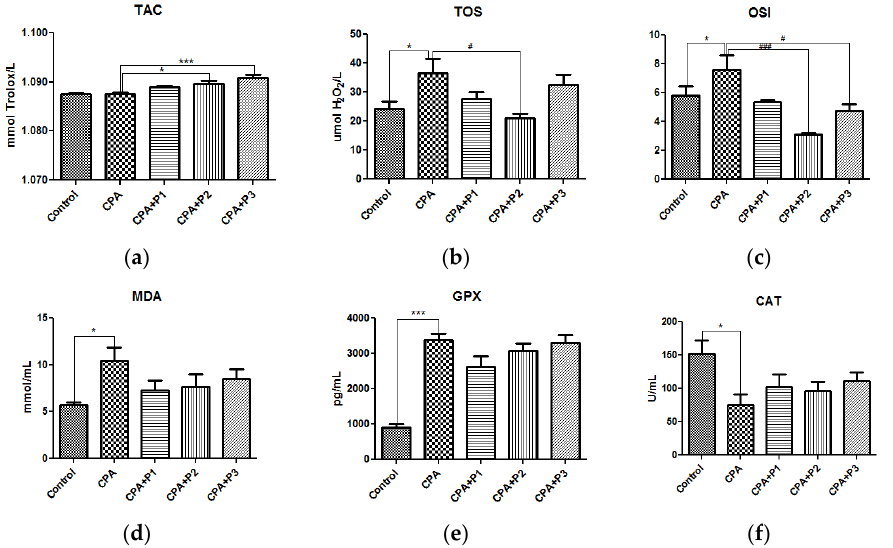
Figure 1. The in vivo antioxidant response of P. sempervirens extract seen in ( a ) TAC, ( b ) TOS, ( c ) OSI, ( d ) MDA levels, ( e ) GPX and ( f ) CAT activities in serum of Control, CPA, and CPA + P1/P2/P3 exposed animals. Data represent mean ± SEM; One-way ANOVA followed by Bonferroni’s Multiple comparison test; * Significant at p < 0.05; *** Significant at p < 0.001—compared with Control group; # Significant at p < 0.05; ### Significant at p < 0.001—compared with CPA